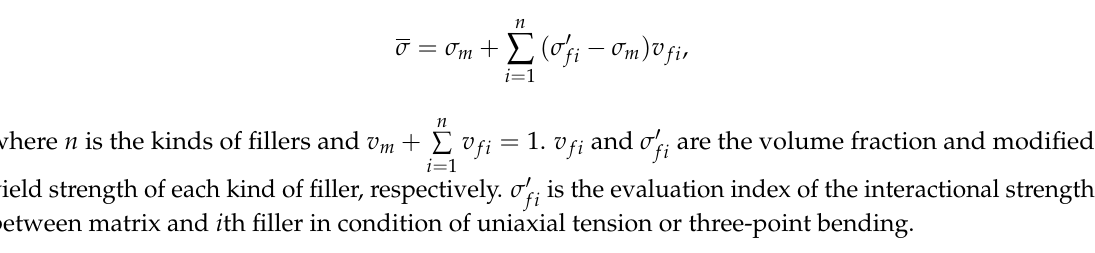
Figure 7. Variation tendencies of yield strengths with ( a ) mass fraction or ( b ) volume fraction.